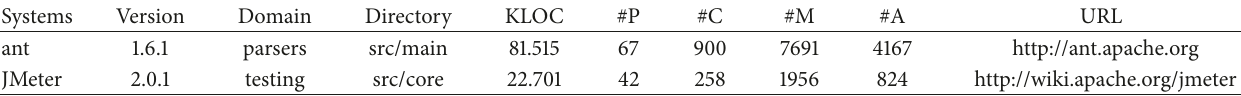
Table 5: Descriptions of the subject software